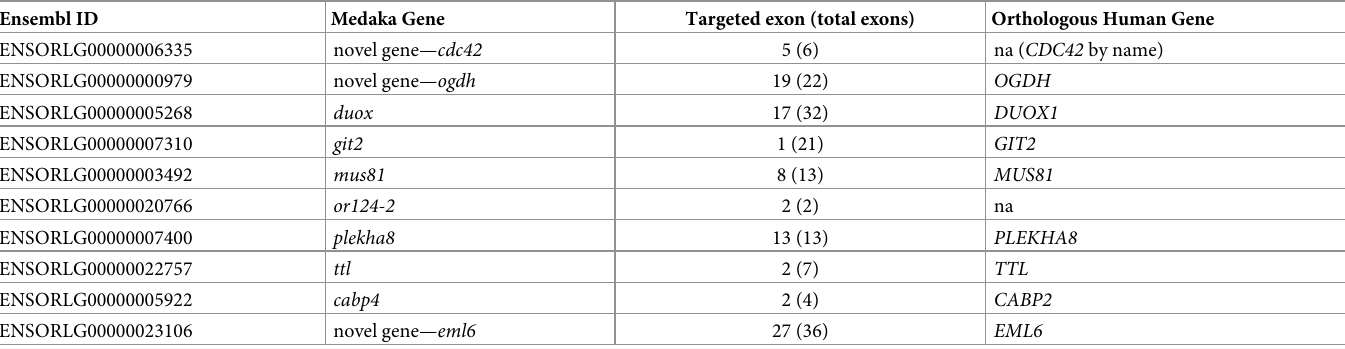
Table 1. List of randomly selected genes.